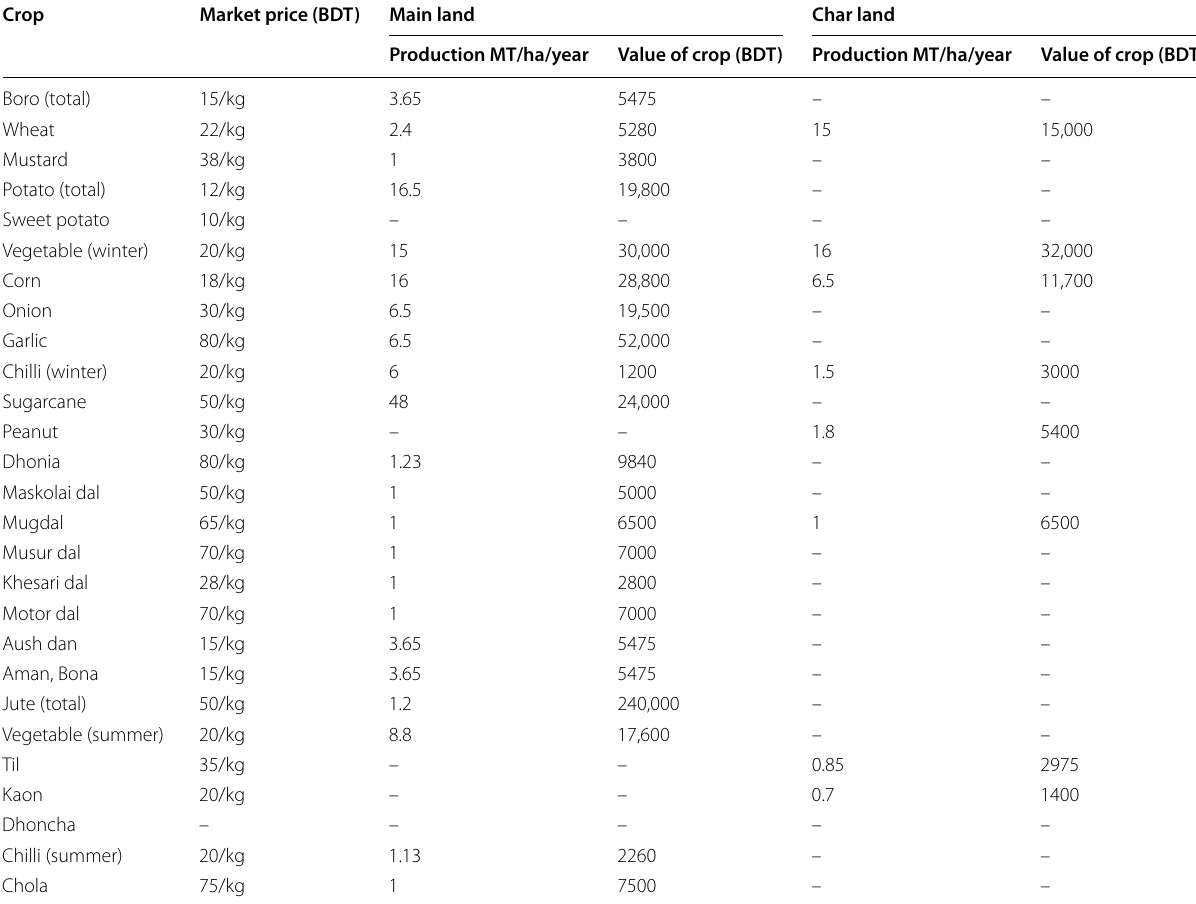
Table 5 Crop production in main lands and the char lands with money value in local market. Source: Agriculture office